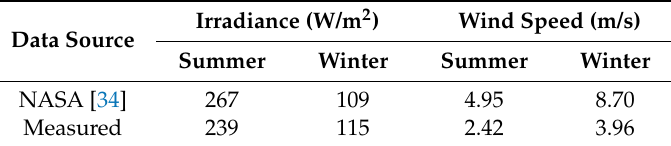
Figure 1. The green building. Table 1. The daily average weather data on the building site [32,34].